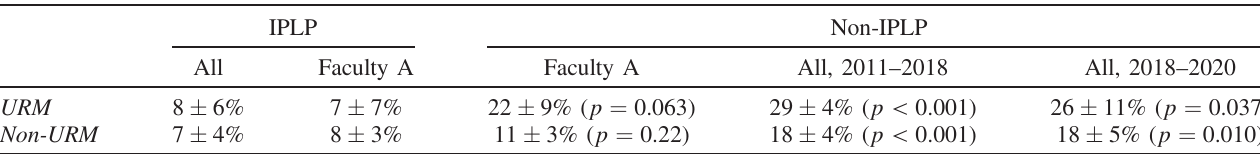
TABLE II. Average DFW rates for the 2018-2020 IPLP classes, and classes not using the IPLP format. Uncertainty intervals indicate standard deviations over N ¼ 14 semesters for 2011-2018 (910 URM, 1954 non-URM students) and N ¼ 4 semesters for 2018-2020 (165 URM, 438 non-URM students). Faculty A data includes N ¼ 3 sections of IPLP (102 URM, 137 non-URM students) and N ¼ 4 sections of non-IPLP (129 URM, 215 non-URM students). Statistical p -values are based on comparison to the IPLP data (comparing “ All ” and “ Faculty A ” separately) and are calculated based on 2-tailed t